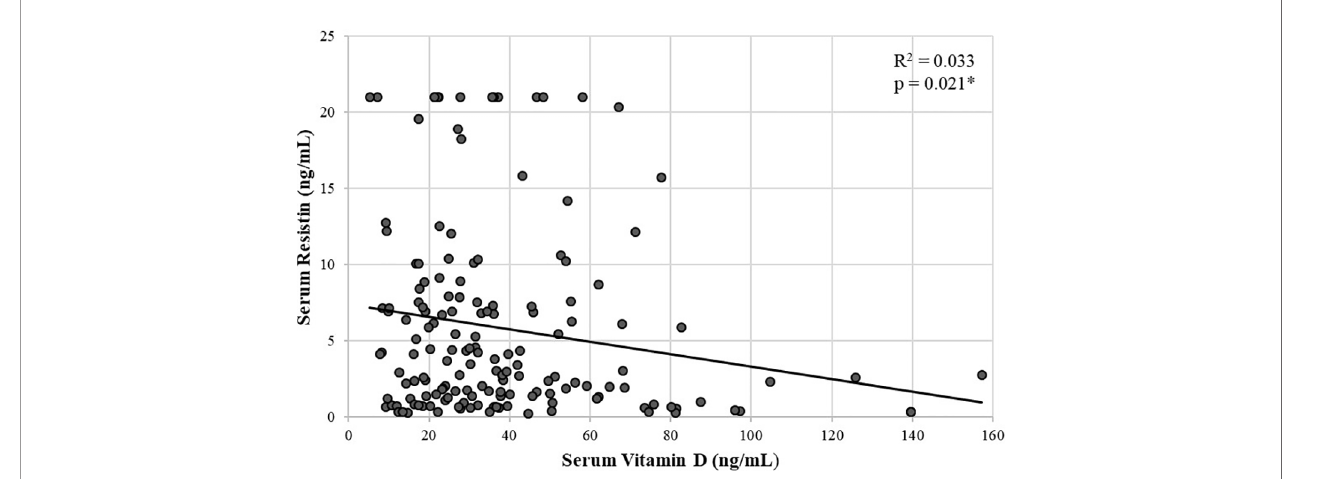
FIGURE 3 | Scatter plot showing a signi fi cant negative correlation between serum resistin and vitamin D in postmenopausal females using spearman ’ s rho correlation coef fi cient. *p < 0.05 is statistically signi fi cant.